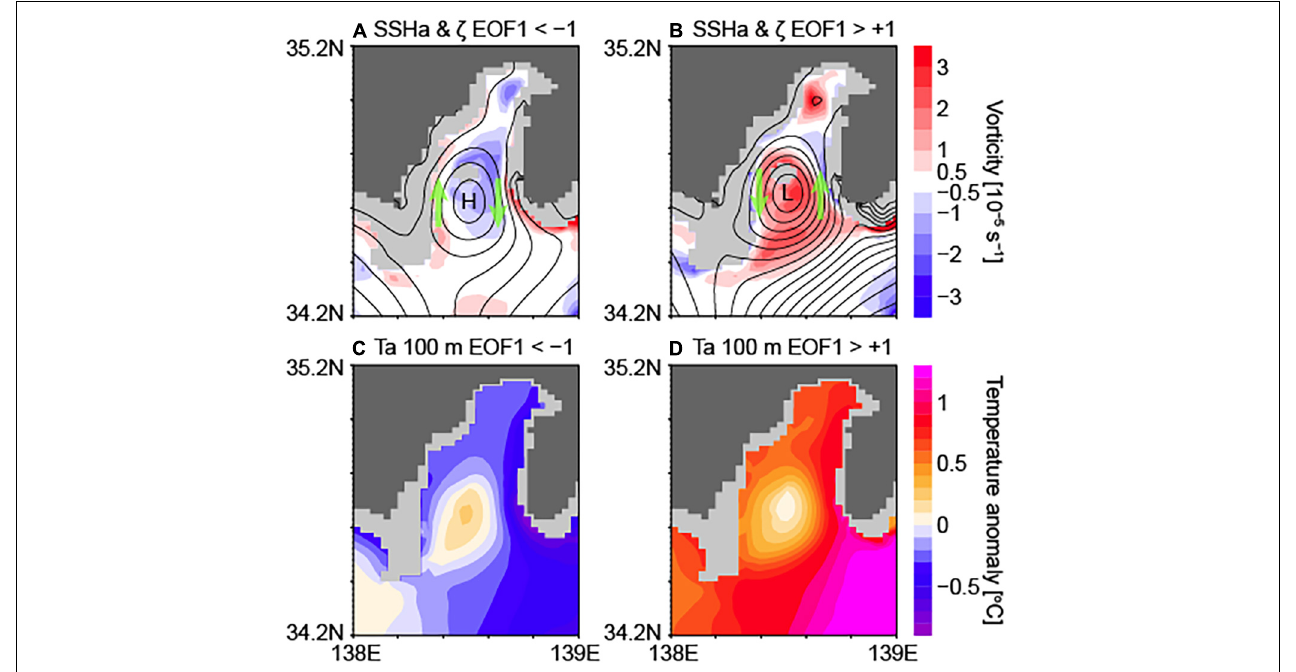
FIGURE 12 | (A,B) Distributions of SSH anomalies (contours with 1 cm intervals) and relative vorticities at 100 m depth (shading). (C,D) Distributions of potential temperature anomalies at 100 m depth. Composites of the daily values when the EOF1 time coefficient is smaller than − 1 (A,C) and greater than +1 (B,D) . Maximum and minimum locations of the SSH anomaly fields are indicated by “H” and “L,” respectively. Broad flow directions are indicated by green